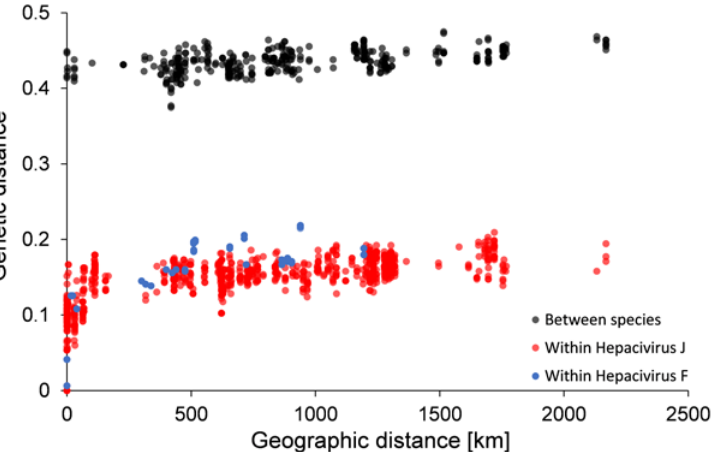
Figure 3. Relationships between pairwise genetic distance ( p ) and geographic distance between BvHV NS3 nucleotide sequences from bank voles collected across Europe. The virus species showed independently significant isolation-by-distance relationships (Mantel tests; both p <